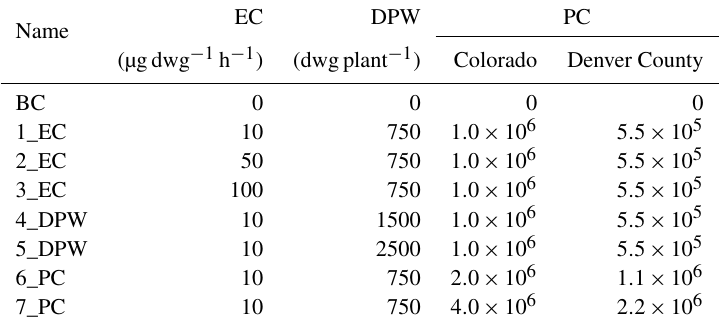
Table 1. Simulation scenarios and assumed values for emission capacity (EC) rate, dry plant weight (DPW), and the plant count (PC) for Colorado and Denver County. The base case (BC) scenario has no cannabis